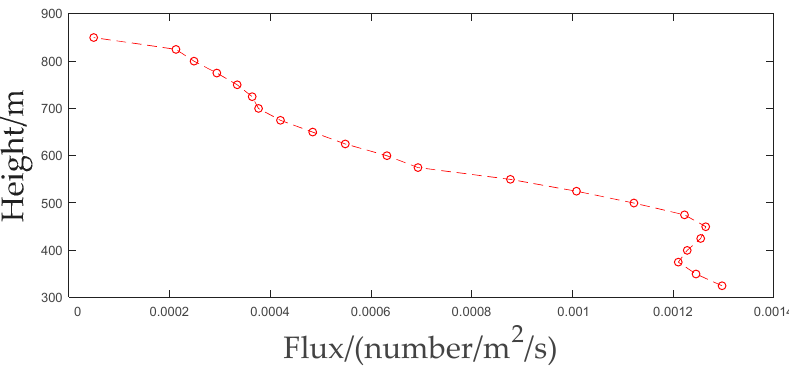
Figure 14. Height–average Flux profile measured.